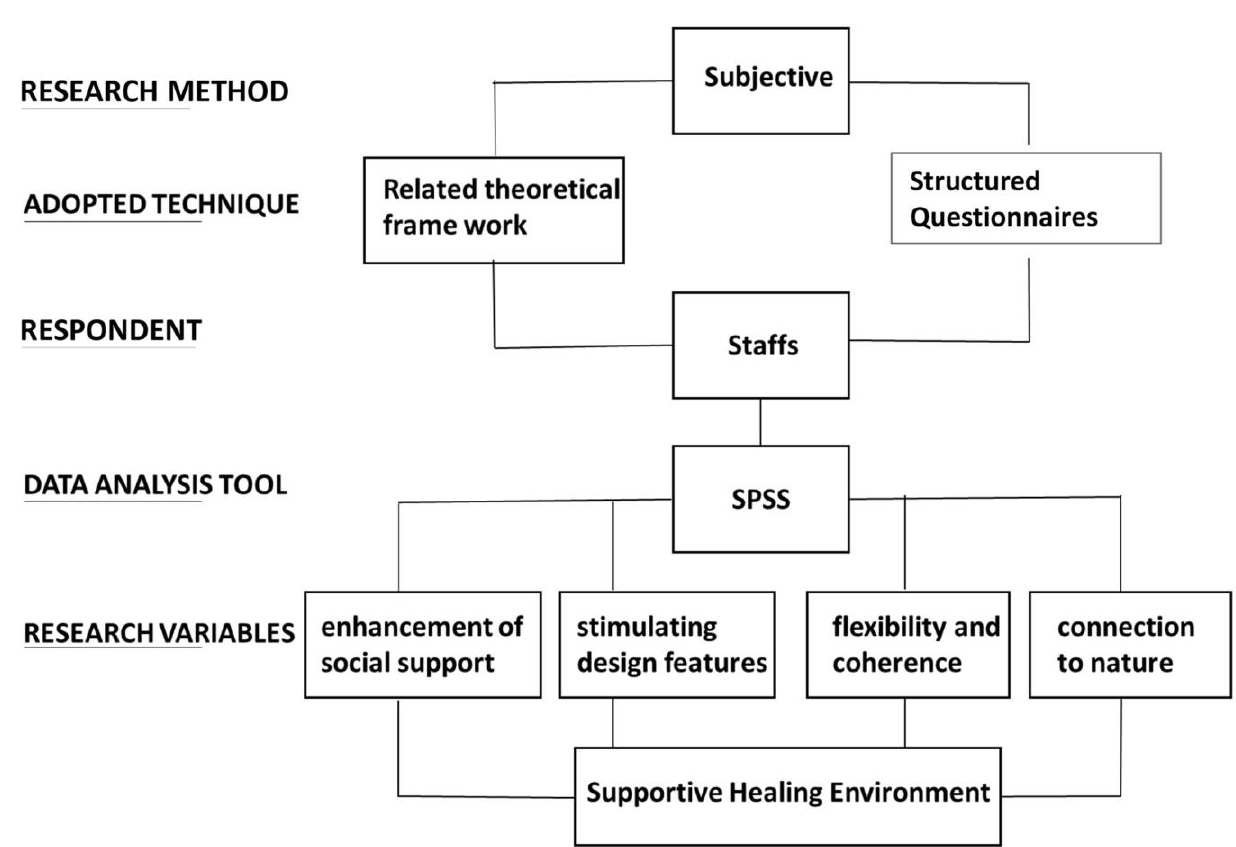
Figure 3. Methodology outline.